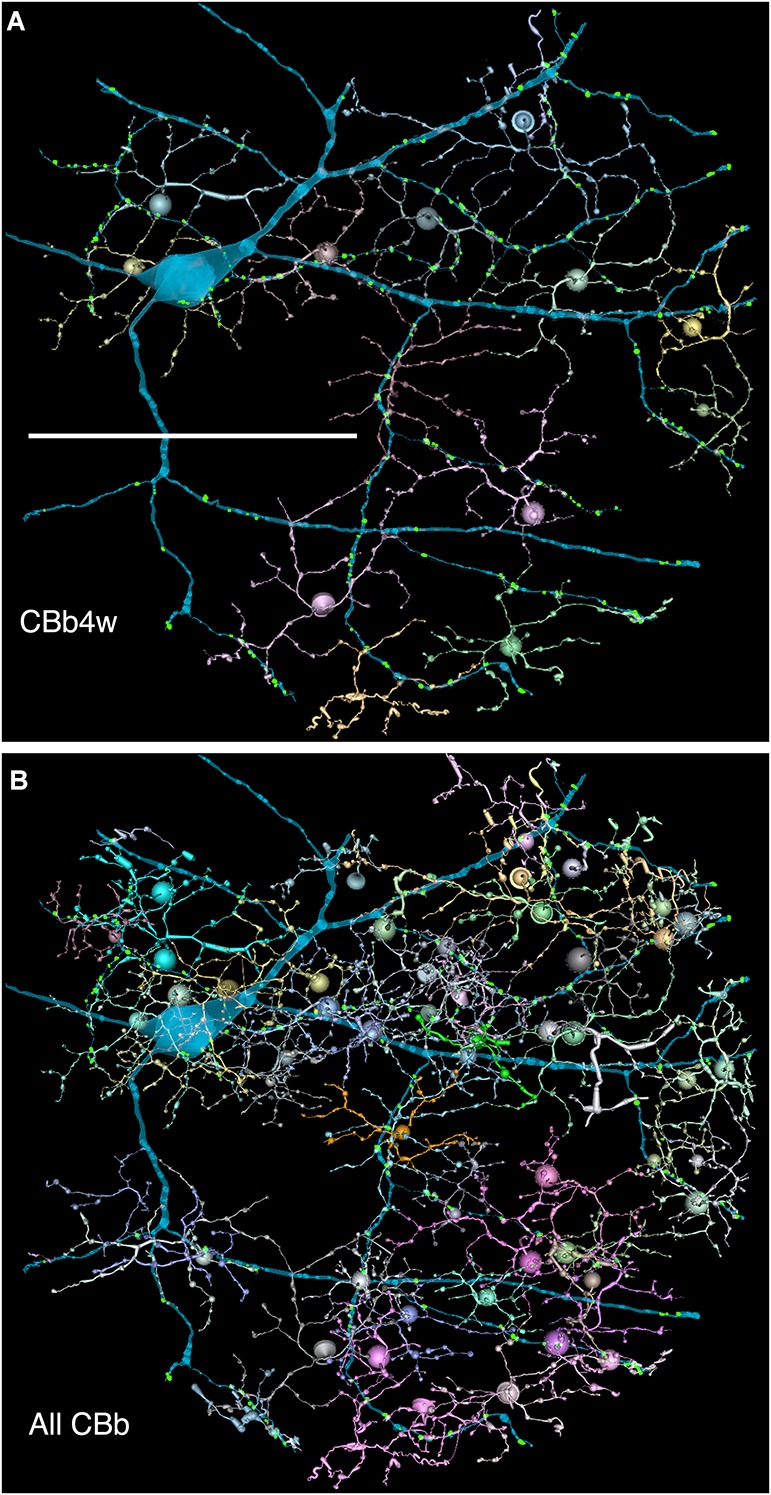
(A,B) Are combined VikingPlot and VikingView renderings. GC 606 and its bipolar cell input. (A) The dominant synaptic ribbon drive (58%) arises from a single class, CBb4w, a coupled homocellular network of ON cone bipolar cells. Each cell is colored individually. (B) The entire CBb input cohort to GC 606. Scale, 100 μm.